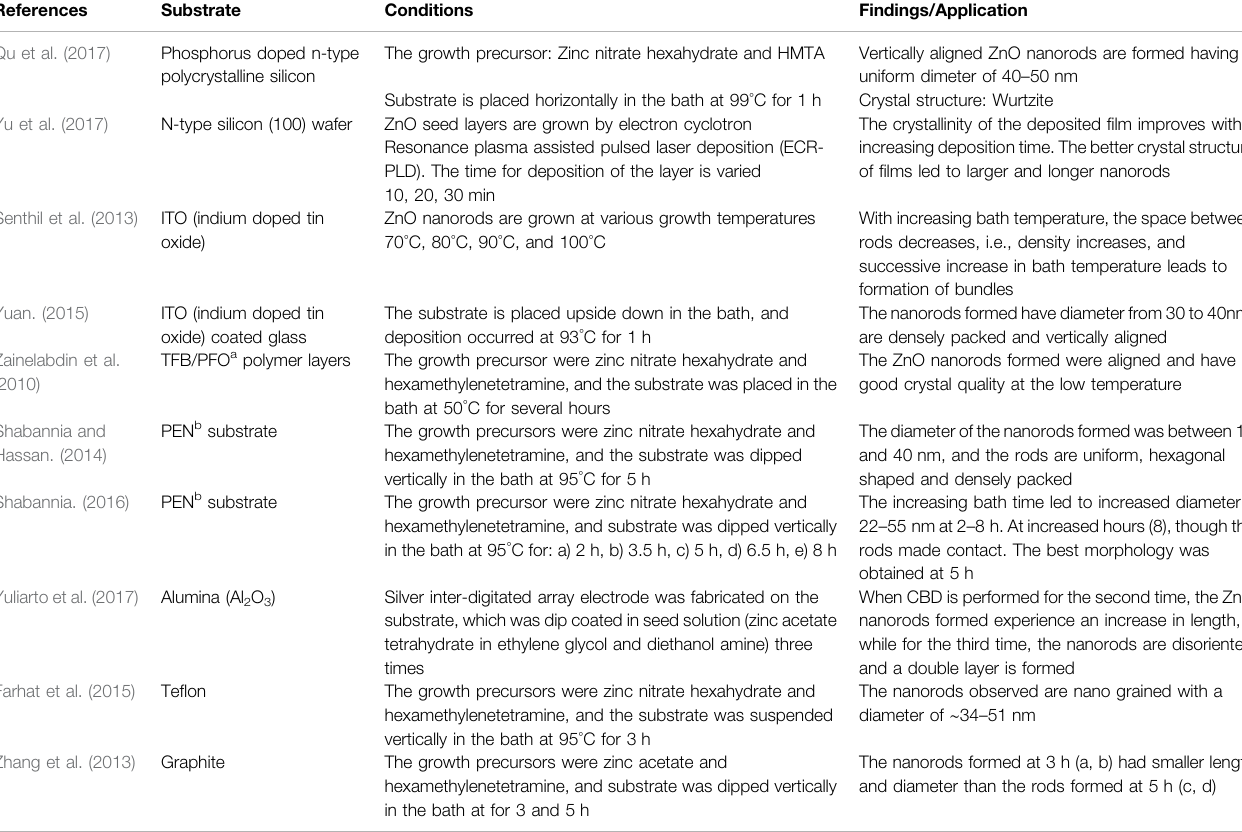
TABLE 2 | Summary of the nanorods synthesized by chemical bath